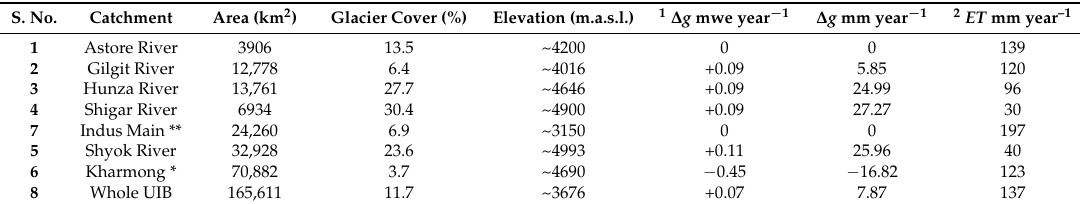
Table 5. Catchment area and adopted glacier mass balance and evapotranspiration of gauged catchment in